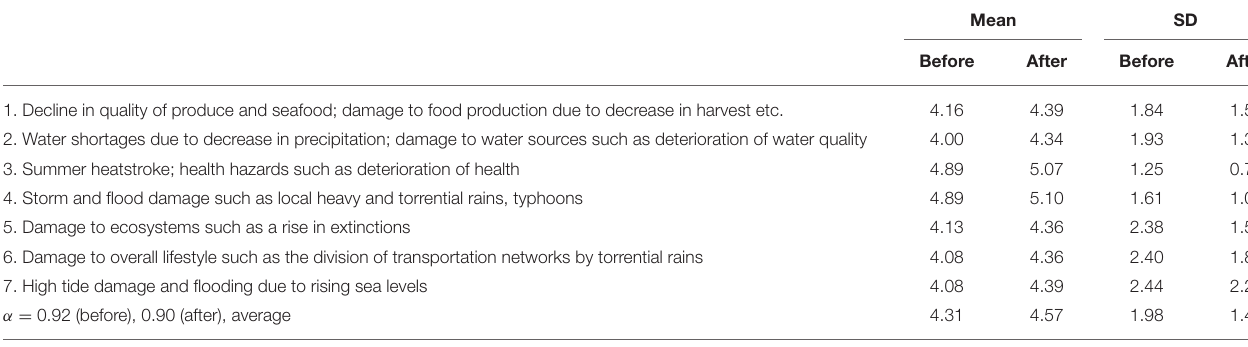
TABLE 3 | Realization of the climate change impacts.